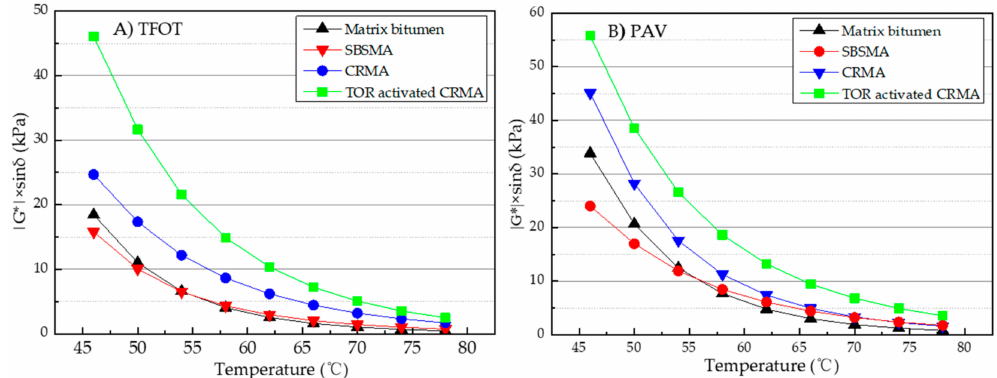
Figure 11. The fatigue factor of asphalt binder samples after aging. ( A ) thin film oven test (TFOT); ( B ) pressure aging vessel (PAV).